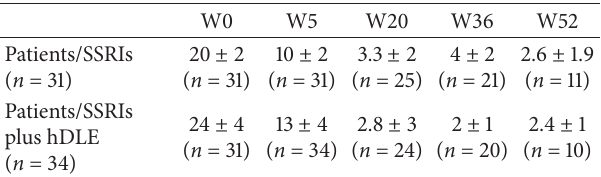
Values are given as mean ± standard deviation.